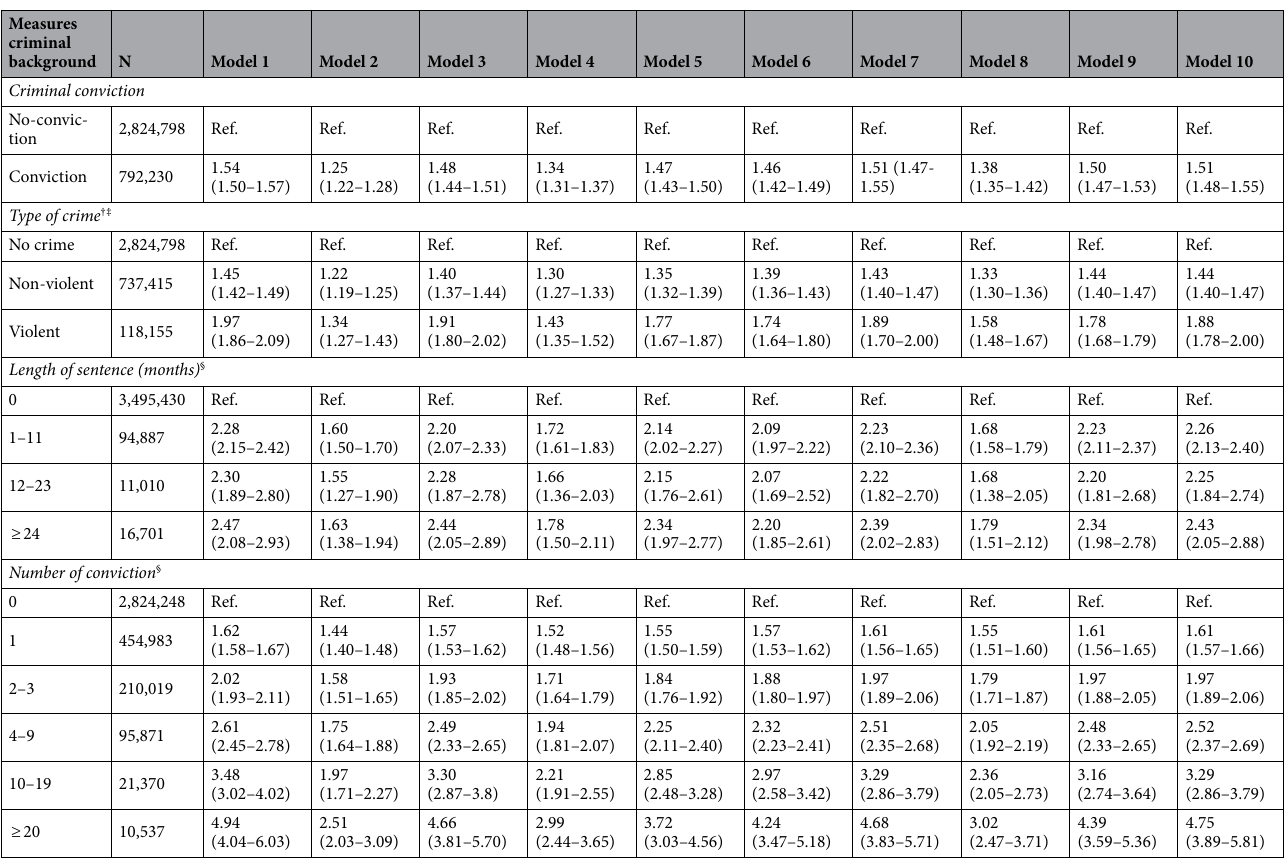
Table 3. Association between the four measures for the criminal background and dementia as hazard ratios (HR) with 95% confidence intervals (CI). Model 1: HR (95% CI) adjusted for sex and birth year. Model 2: Full Adjustment for all covariates. Model 3: HR (95% CI) adjusted for sex and birth year and educational attainment. Model 4: HR (95% CI) adjusted for sex and birth year and mental health disorders. Model 5: HR (95% CI) adjusted for sex and birth year and physical health disorders. Model 6: HR (95% CI) adjusted for sex and birth year and depression. Model 7: HR (95% CI) adjusted for sex and birth year and anxiety. Model 8: HR (95% CI) adjusted for sex and birth year and substance use disorder. Model 9: HR (95% CI) adjusted for sex and birth year and schizophrenia spectrum disorders. Model 10: HR (95% CI) adjusted for sex and birth year and bipolar disorder. N Number of individuals. † Type of crime is a time-varying exposure. ‡ Type of crime: individuals with convictions can contribute to both non-violent and violent types of crime. § Number of convictions and Length of the sentence are time-fixed exposures showing the total number of convictions or sentence months in the individual´s